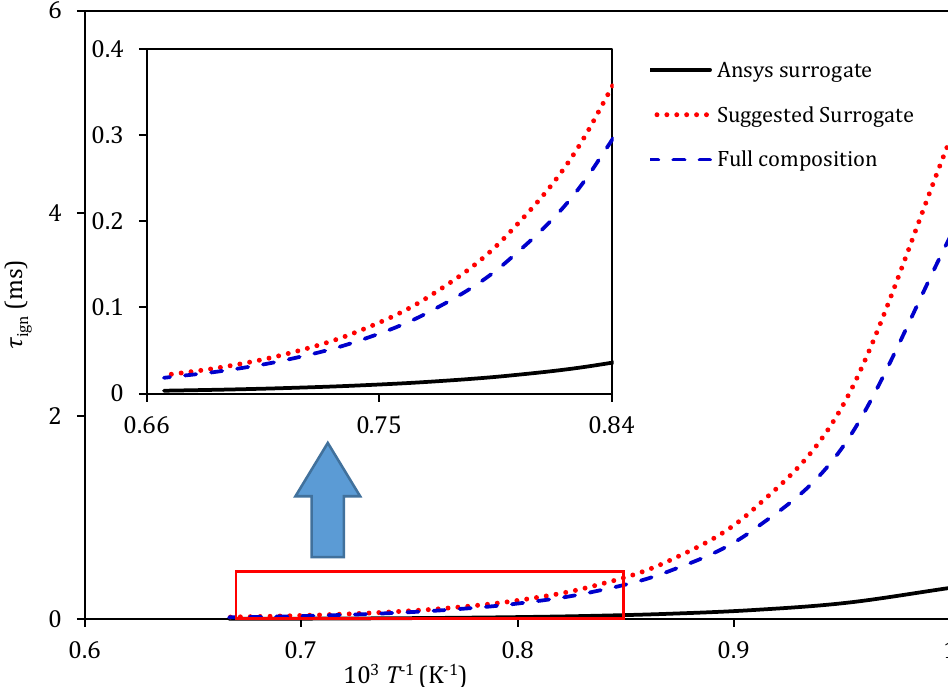
Figure 9. Ignition time delay of the full composition of kerosene fuel and its surrogates (suggested surrogate and ANSYS surrogate) at pressure of 4 MPa and equivalence ratio of 1.